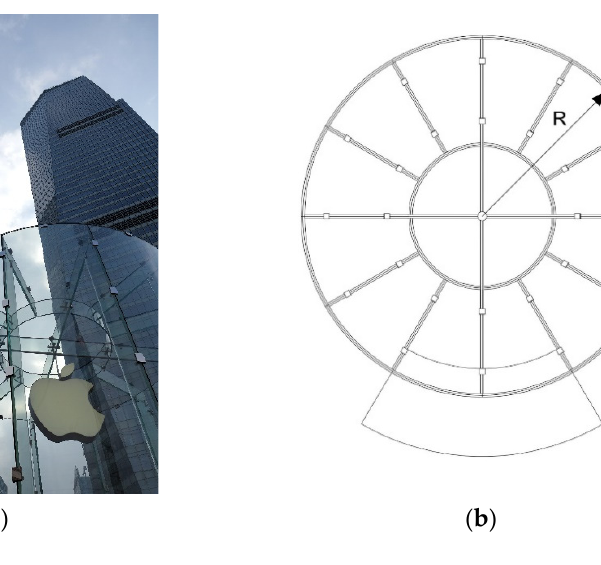
Figure 16. The Apple Retail Store in Shanghai Pudong: ( a ) view of the transparent pavilion (WikimediaCommons/Kallera/CC-BY-S-4.0); ( b ) roof plan (figure by the author); ( c ) shape of the glass pane (figure by the author).